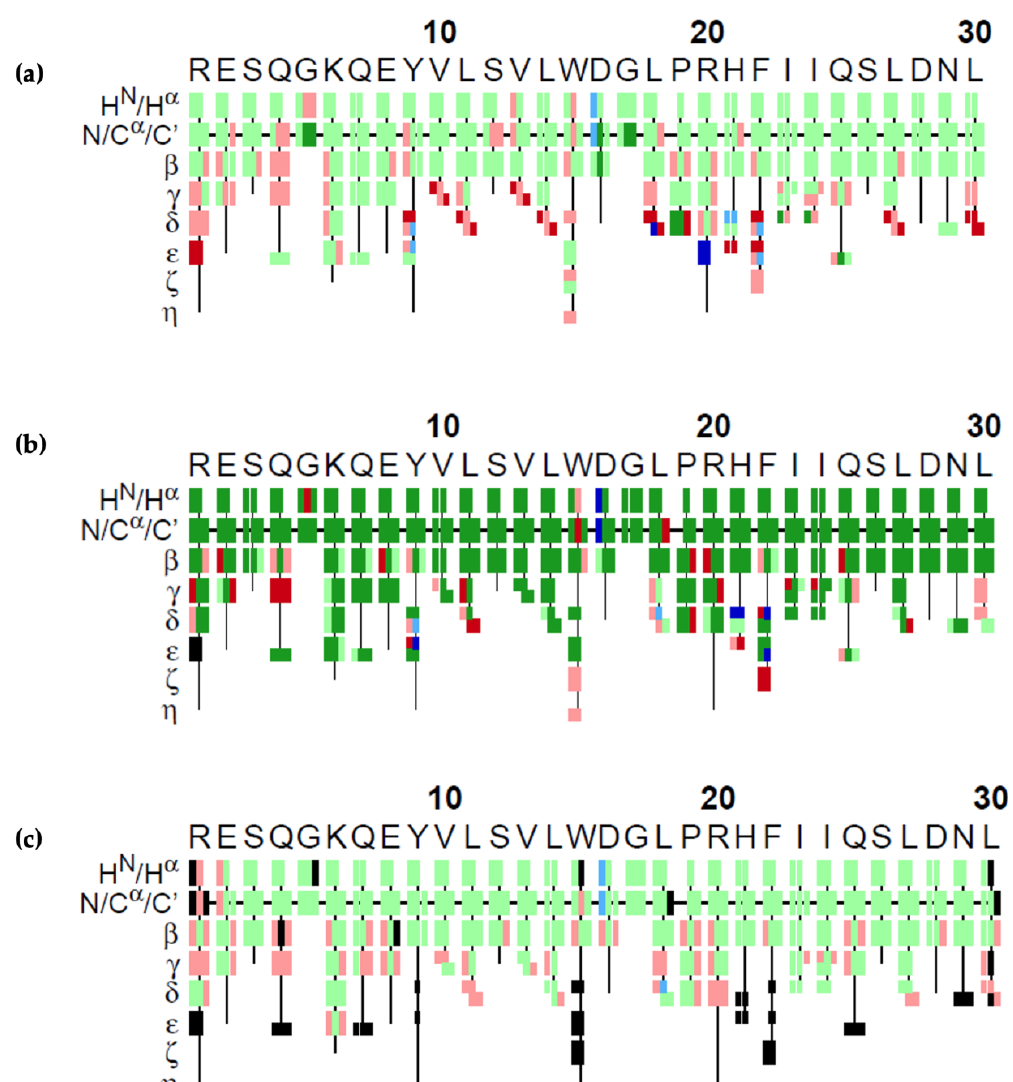
Figure 7. Graphical representation of assignments obtained by the ( a ) GA, ( b ) FLYA, and ( c ) PINE algorithms. Colored rectangles represent the correctness of the assignment of a single atom. Green means that the chemical shift assigned is marked as correct , i.e., the difference between the assigned value and the reference value is smaller than the experimental tolerance of 0.03 ppm for 1 H, 0.4 ppm for 13 C, and 0.4 ppm for 15 N. Red means that the assigned chemical shift value is not in that range, i.e., wrong . Blue means that the algorithm assigned the atom; however, there does not exist a reference value for that atom to compare. Black indicates that there is a reference chemical shift value for that atom; however, the algorithm did not assign it. In the case of FLYA, dark-colored rectangles indicate that 80% of the 20 independent runs yielded to the same result. The H N /H α row shows the atoms H N and H α atoms of the residues. Similarly, the N/C α /C’ shows the results for the N, C α and C’ atoms. The lines β , γ , δ , ε , ζ , and η show the assignments of the atoms in